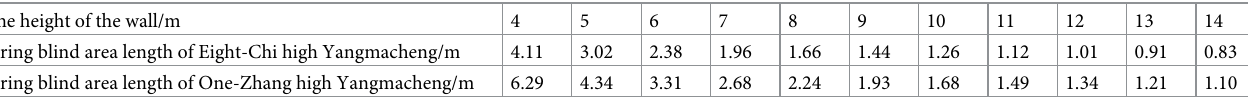
The function images shown above can be obtained from the simulation models correspond- ing to the eight Chi (2.56 m) high and ten Chi (3.20 m) high Yangmacheng, respectively. The absolute value of the slope of the two curves is gradually decreasing. In other words, when the wall increases a fixed height, the firing blind area width decreases. The decreased value is not Table 5. Firing blind area length under different wall heights. The height of the